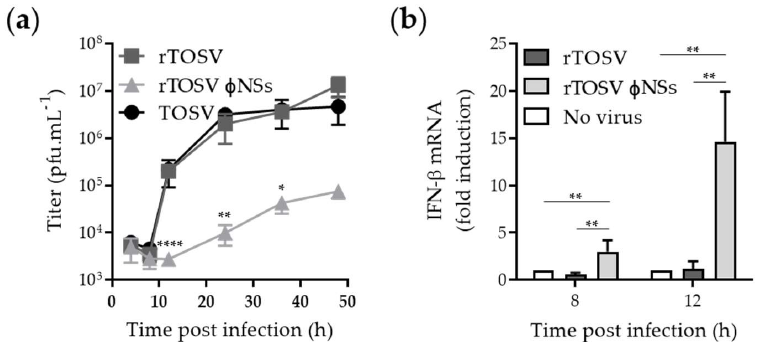
Figure 6. TOSV NSs counteracts IFN-b mRNA expression in A549 cells. ( a ) A549 cells were infected with TOSV, rTOSV, and rTOSV